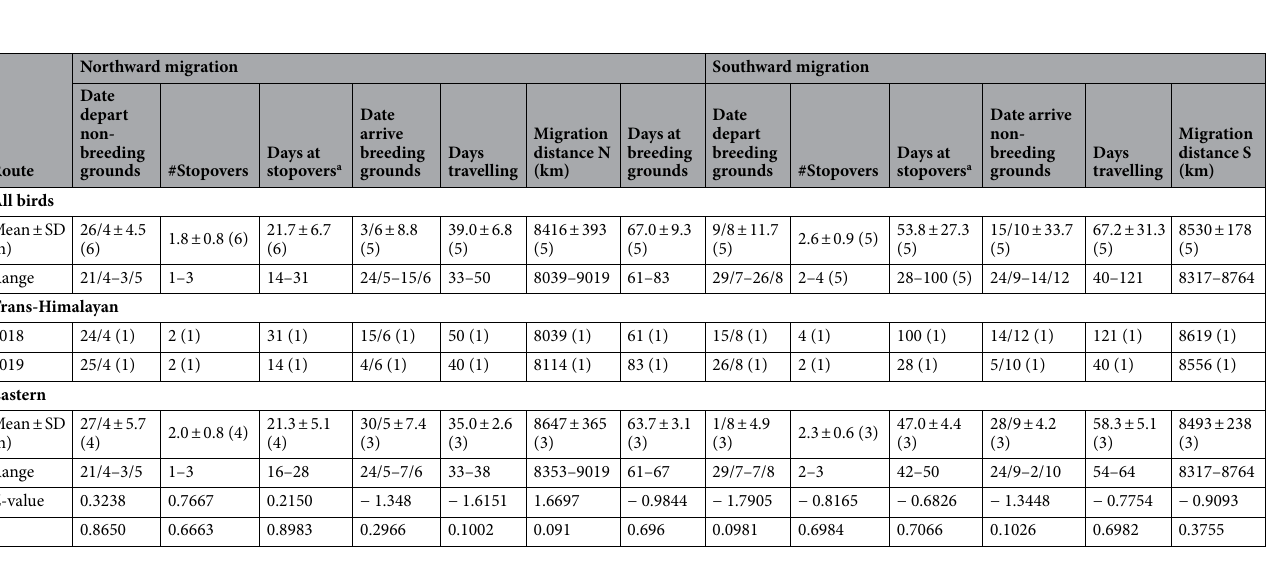
Table 3. Summary of migratory movements of adult Whimbrels traveling between Singapore and their breeding grounds as determined by satellite transmitters. Z-values and P-values are from permutation tests comparing trans-Himalayan and eastern migration routes. All dates are indicated by day/month/year in SGT(UTC + 8). a See methods. For the list of stopover sites see Supplementary Table